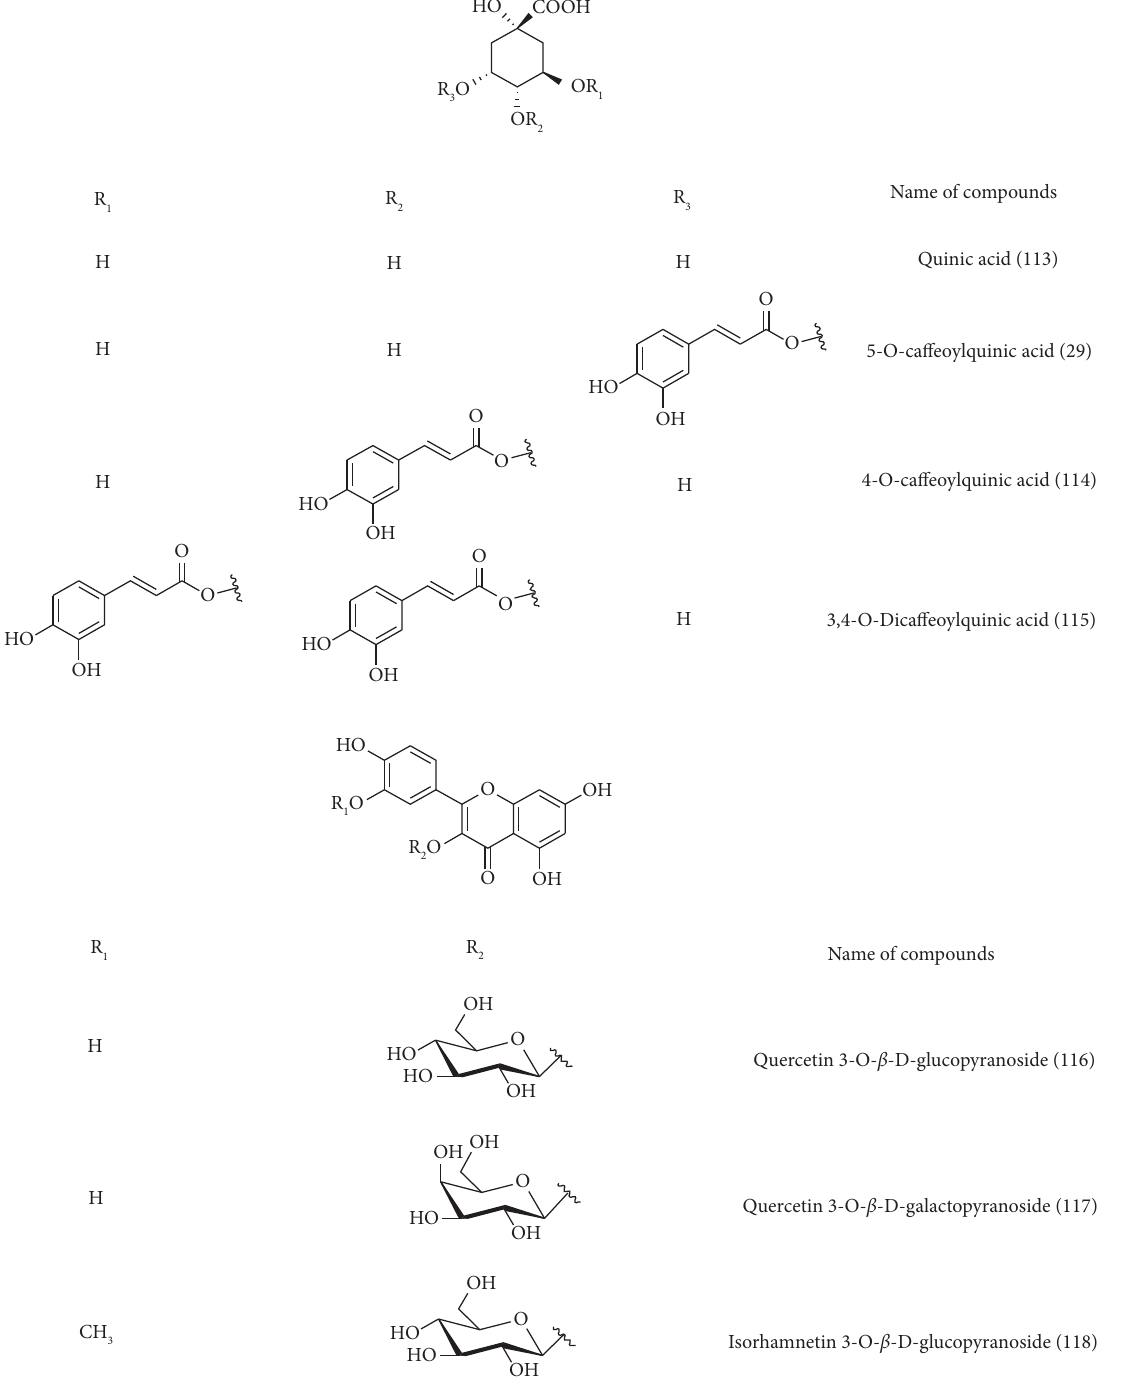
Figure 5: Structure of phenolic compounds detected in C.